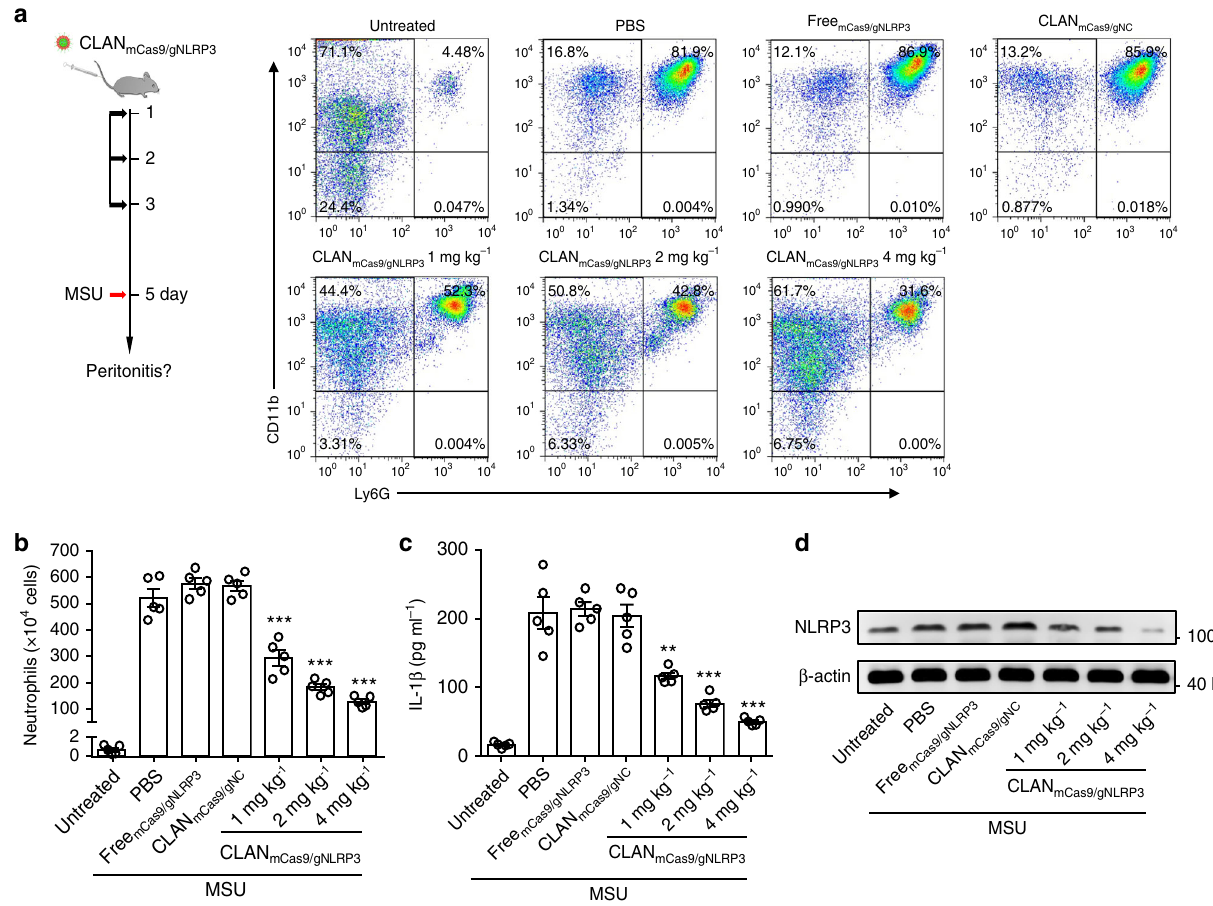
Fig. 6 Mitigation of MSU-induced peritonitis via CLAN mCas9/gNLRP3 -mediated NLRP3 knockout. a Therapy scheme and FACS analysis of neutrophil recruitment in the peritoneal cavity of MSU-induced peritonitis. n = 5 per group. b – d Total number of neutrophils in fi ltrated in the peritoneal cavity ( b ), ELISA of IL-1 β production in peritoneal lavage fl uid ( c ), or immunoblot analysis of NLRP3 knockout ef fi ciency in peritoneal macrophages ( d ) of mice pre- treated with CLAN mCas9/gNLRP3 or other formulations and then challenged with MSU. The data are representative of two independent experiments ( a , d ) or are shown as the means ± SEM of n = 5 ( b , c ). Two-way ANOVA ( b , c ) ** P < 0.01, *** P <